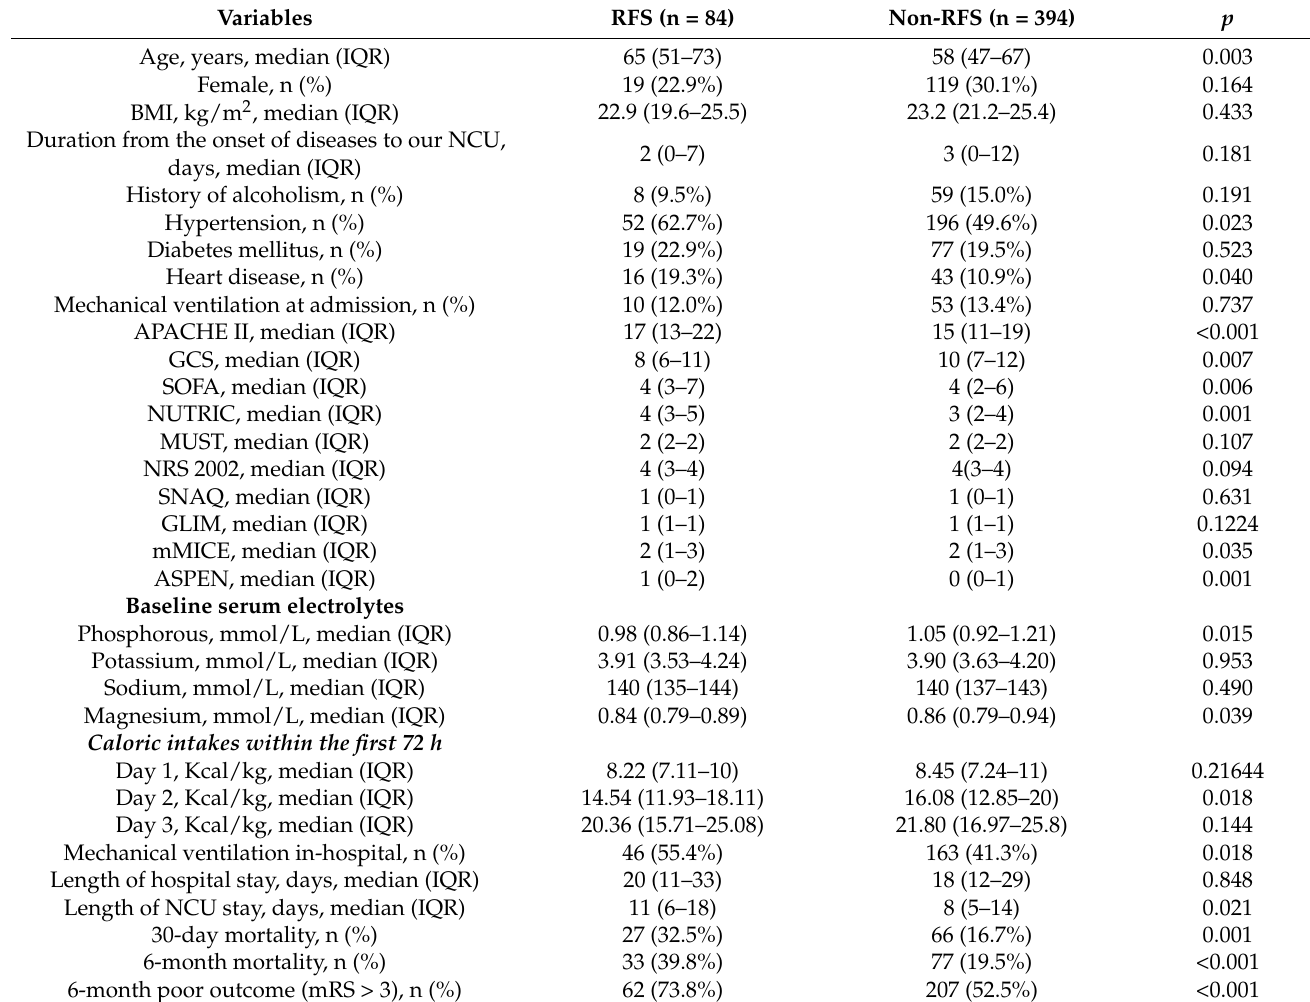
Table 1. Patient characteristics, based on RFS and non-RFS